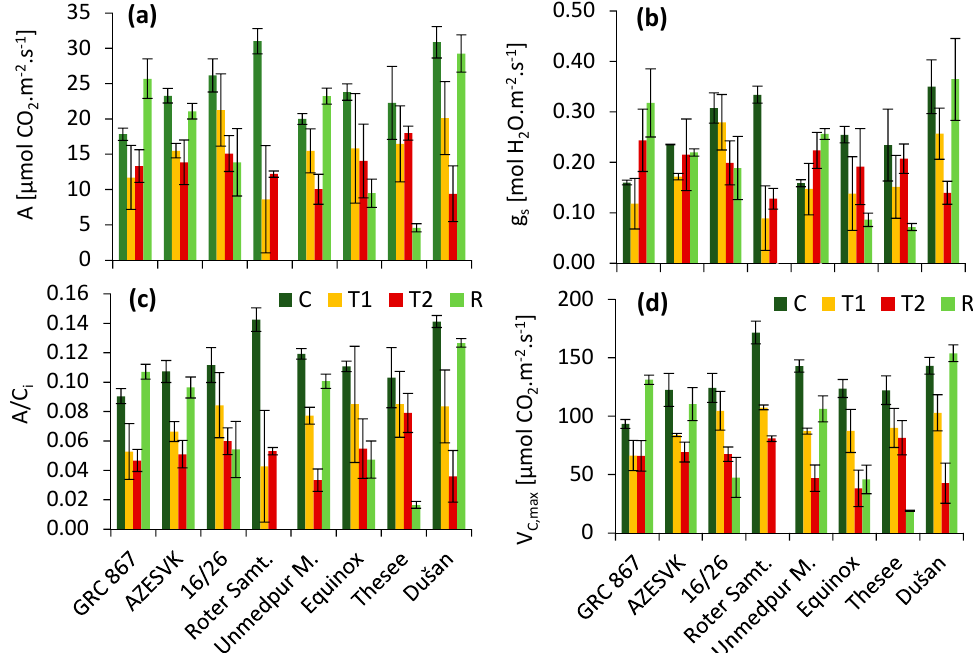
Figure 2. Heat effect on parameters measured by Li-6400 ( a ) A, photosynthesis rate; ( b ) g s , stomatal conductance; ( c ) A/C i , photosynthetic rate per unit of internal CO 2 concentration; ( d ) V Cmax , maximum rate of carboxylation based on analyses of A/Ci curves; C, control; T1, thermal effect in the first phase; T2, thermal effect in the second phase; R, recovery phase. Mean values ± SE are presented.